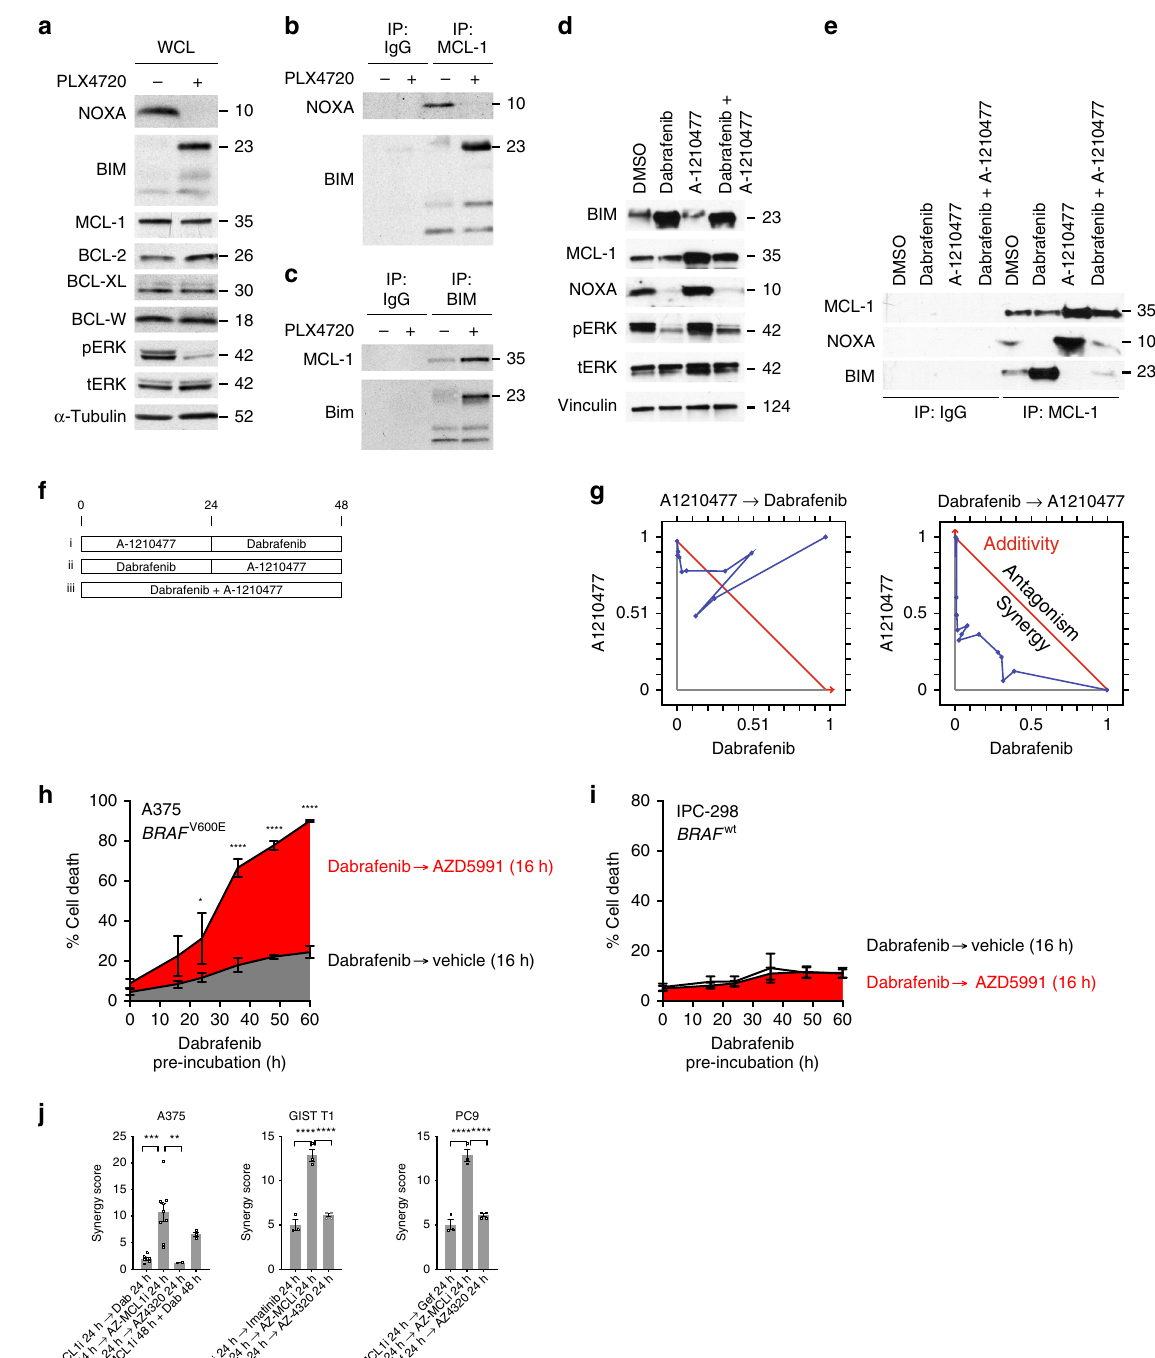
Fig. 4 Targeted therapies recon fi gure apoptotic signaling and create a schedule-dependent vulnerability. a Effect of PLX4720 (1 µ M ) on total levels of NOXA and BCL-2 family members in A375M melanoma cells (input for immunoprecipitation). b Association of MCL-1 with NOXA and BIM following PLX4720 treatment. c Association of BIM with MCL-1 following PLX4720 treatment. d Effect of A1210477, dabrafenib or both on MCL-1 and BIM. e Effect of A1210477, dabrafenib or both on the association of protein levels of MCL-1, BIM, and NOXA. f Scheduling of drug treatments in g . g Representative synergy blot of A-121044 followed by dabrafenib, or reverse, in A375M cells. h Effect of dabrafenib followed by AZD5991 on apoptosis in A375M cells. Cells were treated with vehicle (time 0) or dabrafenib (1 µ M ) for the indicated time, followed by 16 h exposure to AZD5991 (1 µ M ) or equal volume vehicle. Statistical comparison ( n = 4) of different drug schedules was done using two-way ANOVA with Sidak ’ s multiple comparison test. *, adjusted P value < 0.05; ****, adjusted P value, < 0.0001. i Effect of dabrafenib followed by A1210477 on apoptosis in IPC-298 cells ( n = 4). Cells were treated as in h . j Synergy scores of A375M, GIST-T1 or PC9 cells treated with MCL-1 or BCL-2 inhibitors with targeted agents. Statistical comparison was done using one-way ANOVA with Holm – Sidak ’ s multiple comparison test. ****, adjusted P value < 0.0001; ***, adjusted P value < 0.001; **, adjusted P value < 0.01. Error bars indicate mean ± s.e.m. of indicated replicates. See also Supplementary Fig. 4. Source data for all western blots are provided as a Source Data fi